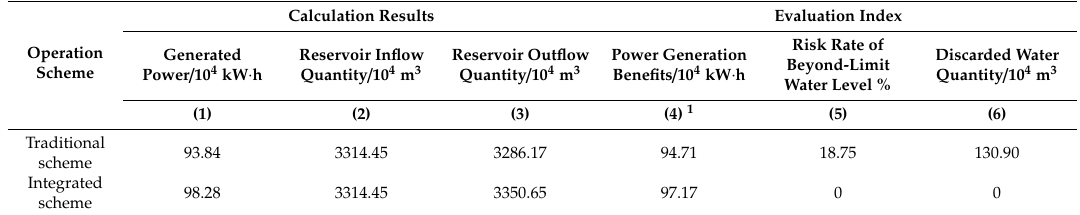
Table 3. Calculation results of the 2nd operating condition.